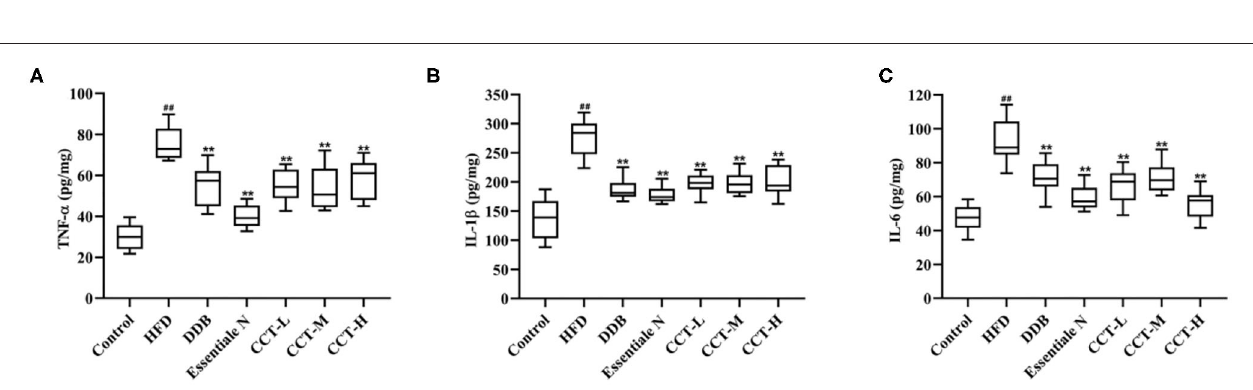
Frontiers in Medicine |